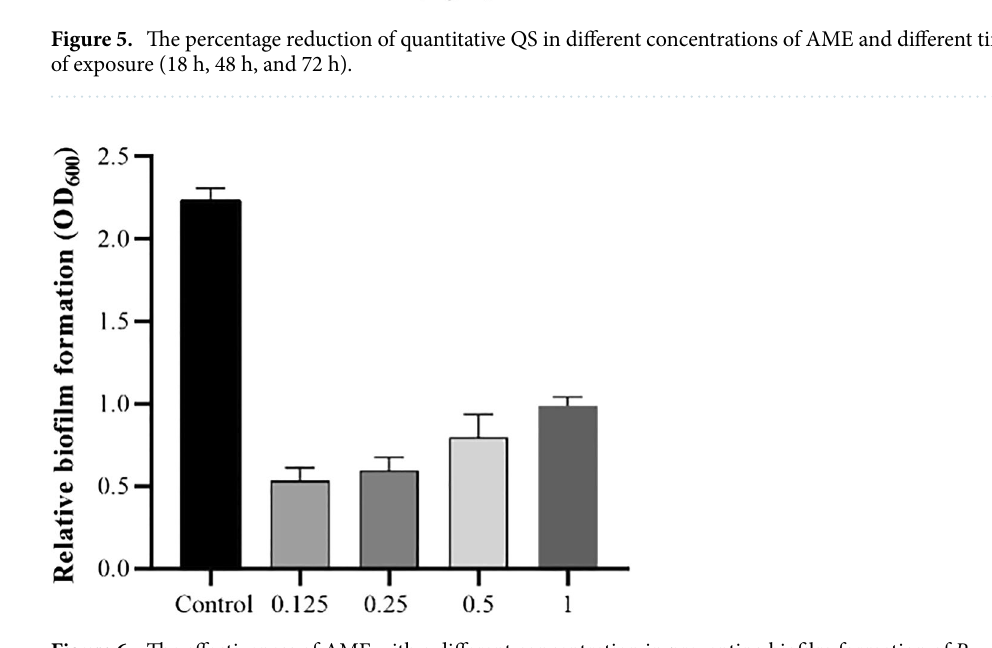
Figure 6. The effectiveness of AME with a different concentration in preventing biofilm formation of P. mirabilis